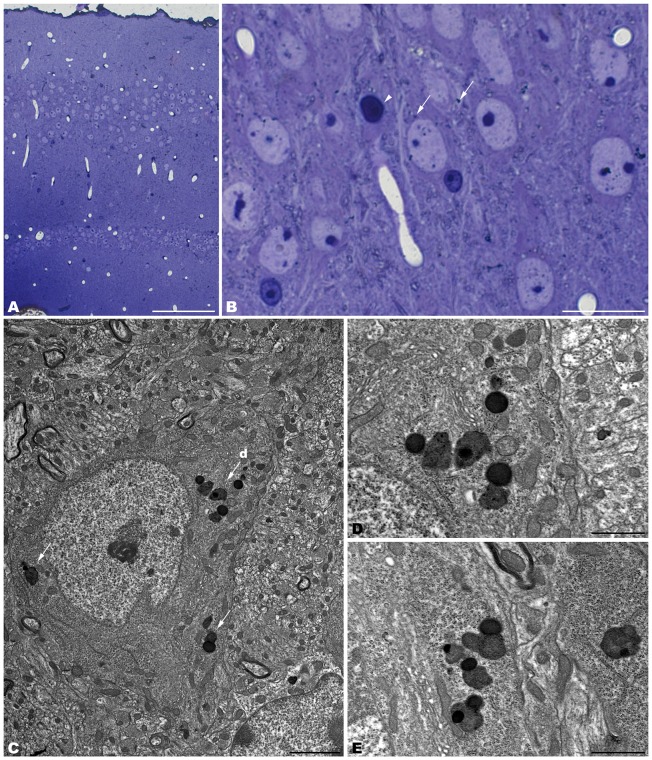
Coronal sections through the CA3 of the hippocampus of 4-month-old tbl/tbl mice. 1.5 μm thick sections show dark degenerative accumulations in the pyramidal cell somata (arrows in B). Condensed dark nuclei are occasionally observed within the pyramidal cell layer (arrowhead in B). Dark accumulations and vacuoles found throughout pyramidal cell cytoplasm have the same ultrastructural features (arrows in C–E) as those found in Purkinje cells and spinal motor neurons. Bars = 100 μm (A), 20 μm (B), 2 μm (C), and 1 μm (D–E).